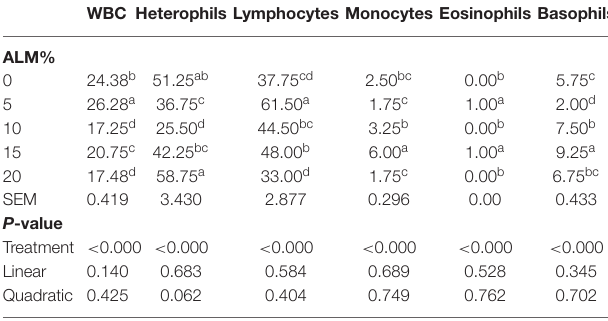
TABLE 4 | Effect of amaranth inclusion leaf meal on blood profiles of Ross 308 broiler